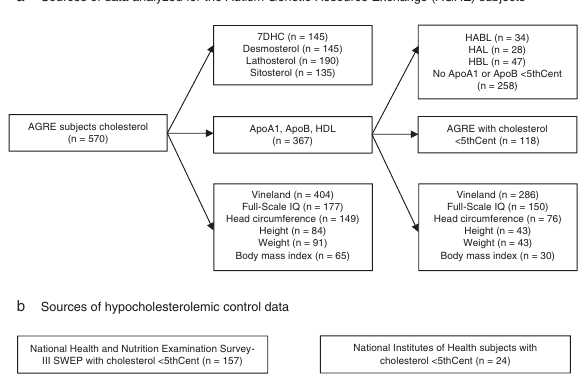
Fig. 1 AGRE and control subject samples and data analyzed. a Cholesterol (CHL) analyses ( n = 570) were performed. HDL, apolipoprotein A1 (ApoA1), and ApoB (each n = 367) analyses were performed in a subset of subjects. AGRE Vineland Scales of Adaptive Behavior, IQ, and physical parameter subsets were analyzed. ApoA1 and ApoB values less than the 5th centile (<5thCent) and greater than or equal to the 5th centile ( ≥ 5thCent) were organized into patterns: HABL (ApoA1 < 5thCent and ApoB < 5thCent); HAL (ApoA1 < 5thCent and ApoB ≥ 5thCent); HBL (ApoA1 ≥ 5thCent and ApoB < 5thCent); Normal (ApoA1 ≥ 5thCent and ApoB ≥ 5thCent). The 118 CHL < 5thCent subjects with apolipoprotein testing, age 4.0 – 17.9 years, were analyzed with CHL < 5thCent control data. b ApoA1 and ApoB analyses were performed with blood samples from National Institutes of Health (NIH) typically developing